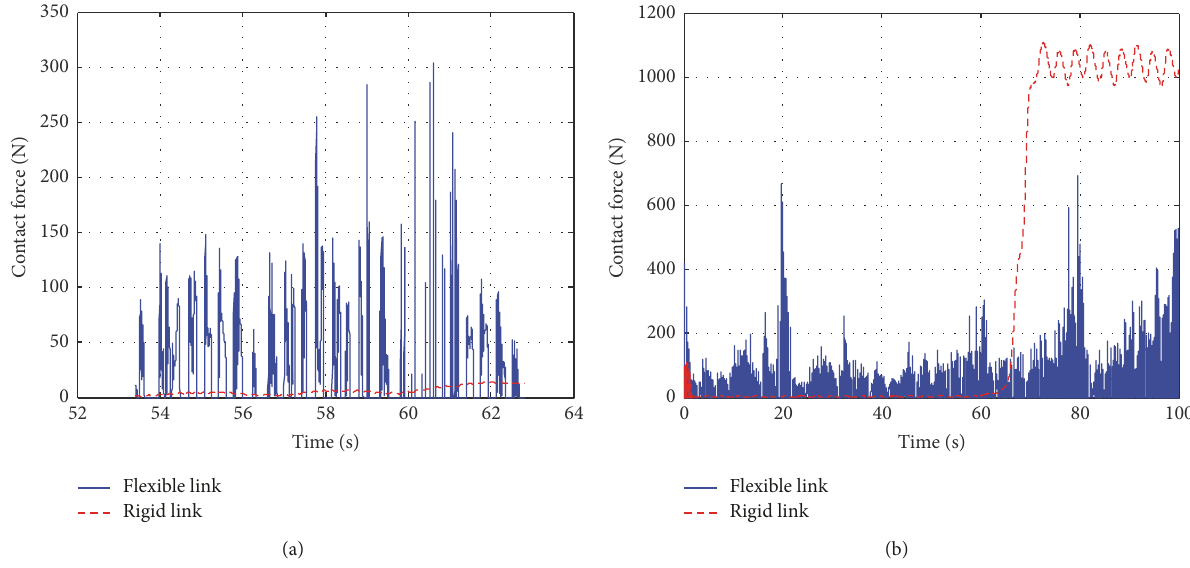
Figure 11: Contact force diagram: (a) within 52 s–64s; (b) within 0